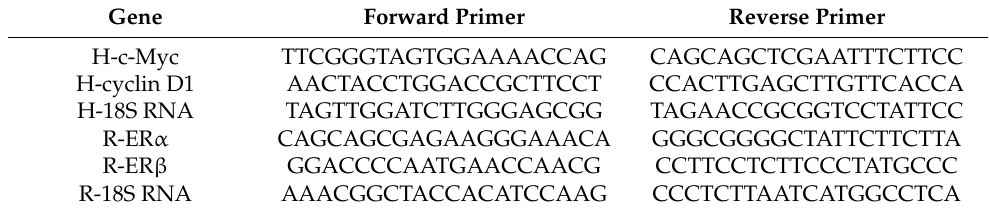
Table 1. Sequence of primers (5 (cid:48) -3 (cid:48) ) used for RT-PCR.